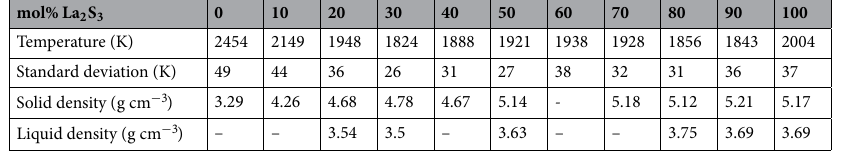
Table 2. Liquidus temperature (K) and densities ( g cm − 3 ) for the initial concentration of La 2 S 3 (mol%), «- »values not